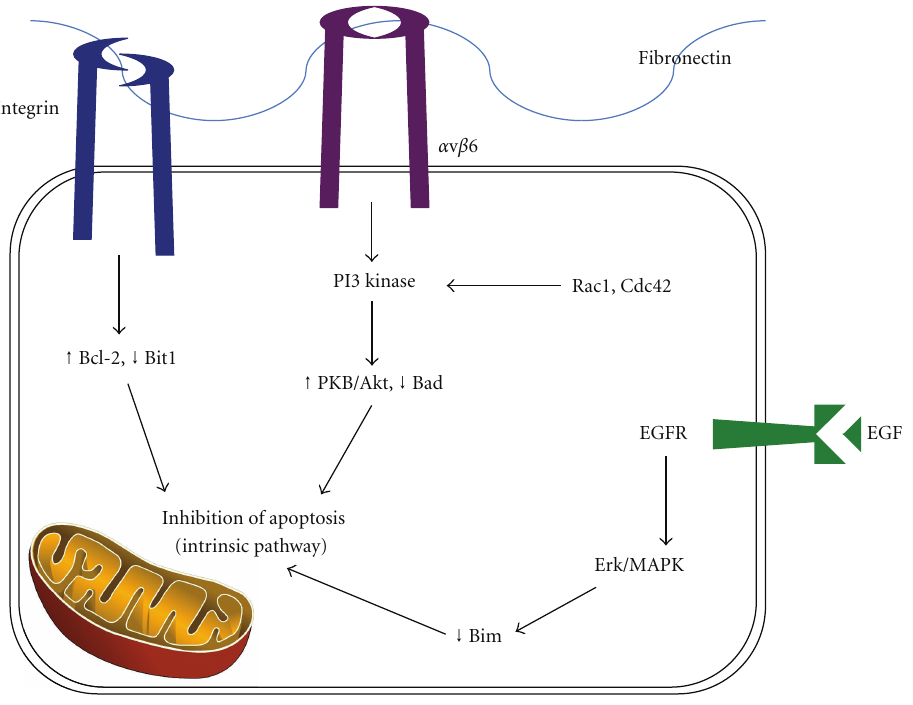
Figure 1: Pathways disrupting